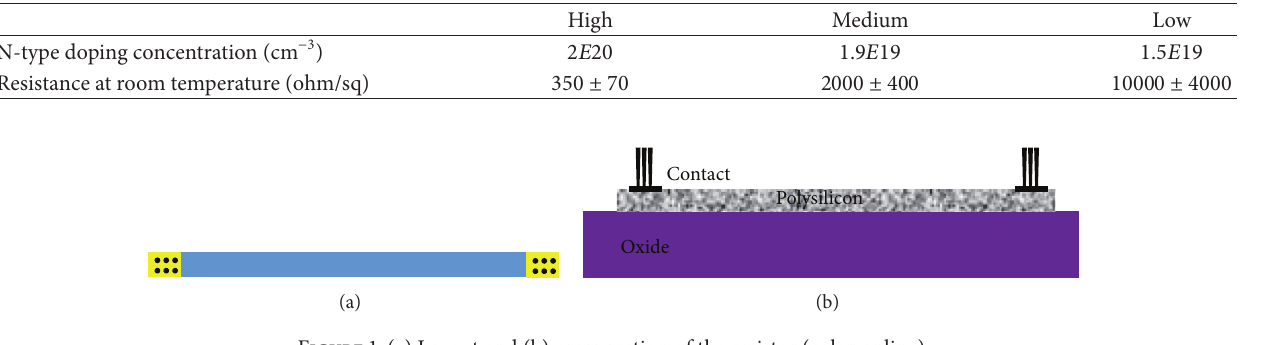
Figure 1: (a) Layout and (b) cross section of the resistor (color online).